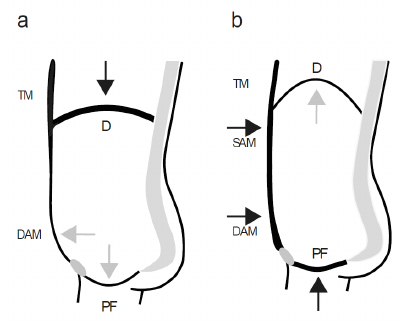
Figure 2. A schematic representation of a mid-sagittal view through the abdominal cavity to demonstrate the movements and contractile state of the muscle groups surrounding the abdominal cavity during ( a ) inspiration and ( b ) physical strain with a “correct” contraction of the PFMs and the anterolateral abdominal muscles during the exhaling of air through an open glottis. D = thoracic diaphragm, PF = pelvic floor, DAM = deep anterolateral abdominal muscles, SAM = superficial anterolateral abdominal muscles, TM = thoracic muscles. The thicker lines indicate a muscle contraction and the thinner lines indicate a muscle relaxation. The black arrows indicate an active force vector and the grey arrows indicate a passive force transmission.